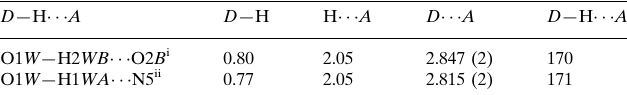
Hydrogen-bond geometry (A˚ , (cid:1)